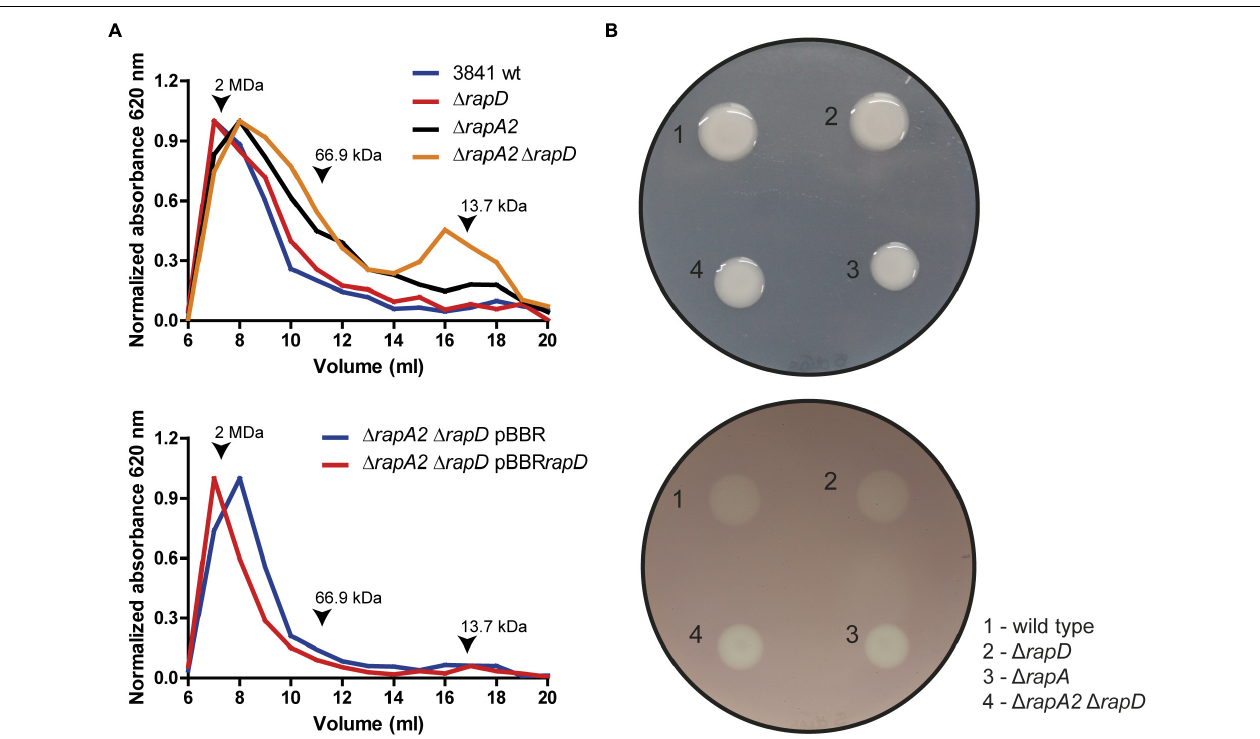
FIGURE 8 | EPS analysis by size exclusion chromatography. (A) Upper panel: Molecular weight (MW) profiling of the EPS from wild type and derivative strains. Lower panel: Effect of RapD overexpression. Arrows indicate molecular weight markers. (B) Glycanase activity assay. Upper panel: The phenotypes of the colonies before revealing the glycanase assay are shown. Lower panel: The glycanase activity from each Rlv 3841 derivative strain is evidenced by a clearing (halo) under the colony after 5 days of incubation on Y mannitol CMC-containing plates.